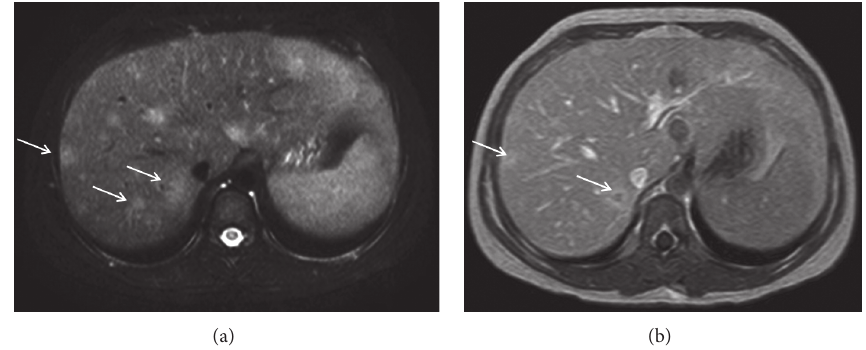
F 1: Abdominal MRI, axial images through the liver: (a) STIR sequence reveals multiple high intensity focal lesions (arrows) with indistinct borders due to perilesional edema in the liver; the lesions demonstrate peripheral enhancing rim in the T1W images aer administration of IV contrast medium (arrows in